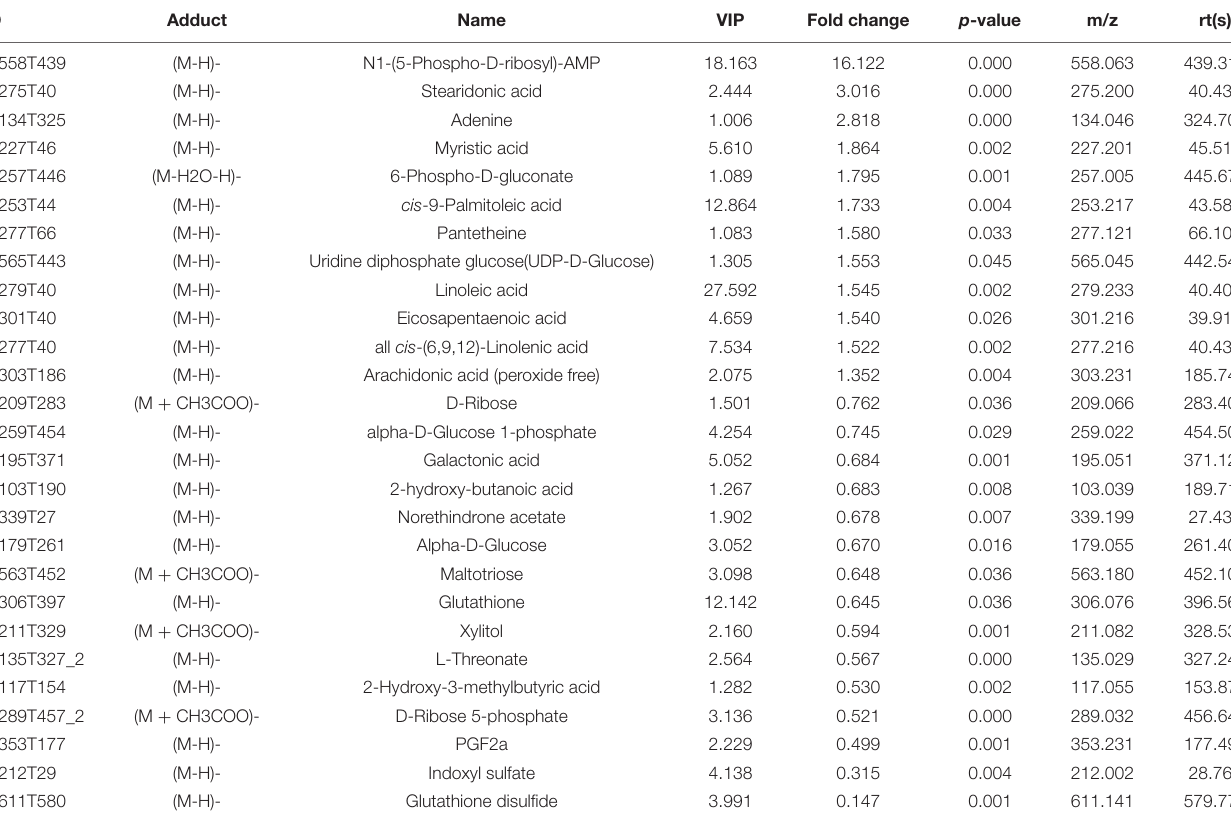
TABLE 2 | The differential metabolites in negative ion